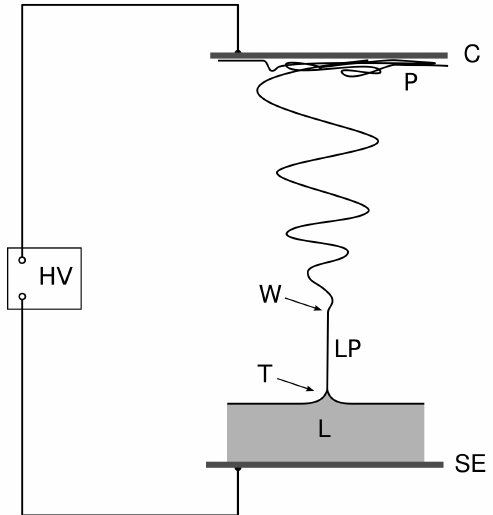
Figure 1. A schematics of electrospinning. HV—high-voltage power supply, SE—spinning electrode, L—liquid to be spun, T—Taylor cone, LP—linear path of the jet, W—whipping instability, P—nanofibrous product, C—collector. Graphics created by Inkscape